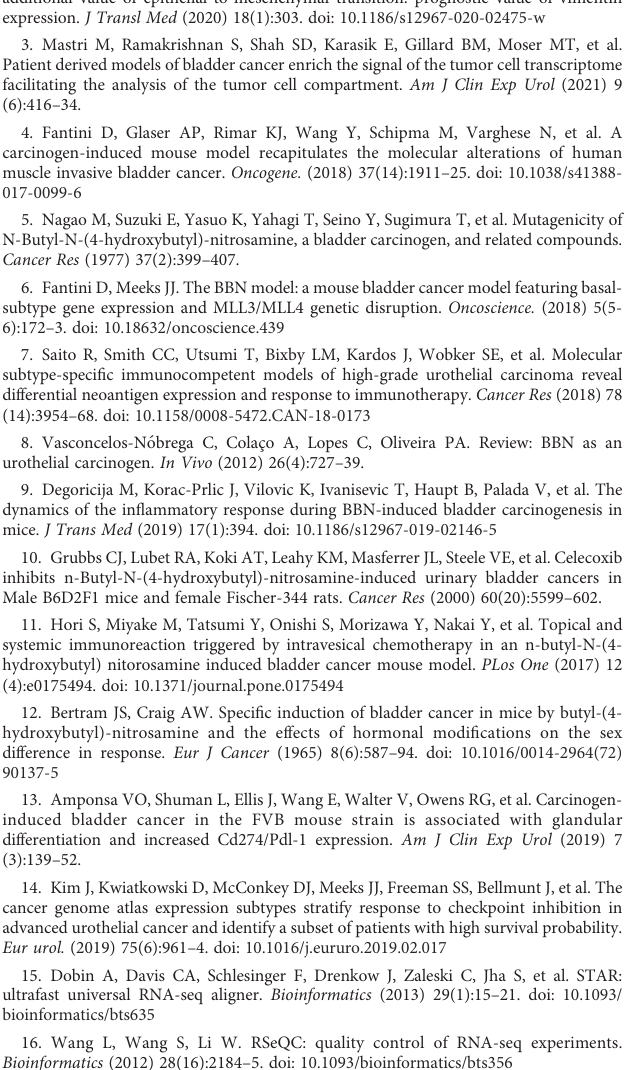
SUPPLEMENTARY FIGURE 5 Volcano plot depicting differential expression analysis. Highlighted genes represent signi fi cant (p.adj < 0.05, log2FC > +/-1) DEGs. SUPPLEMENTARY FIGURE 6 Top enriched pathways in male and female transcriptomes via GSEA. Highlighted pathways represent signi fi cant enrichments (p.adj < 0.05). SUPPLEMENTARY TABLE 1 Gene list of differential expression analysis of male and female Ba/Sq BURP tumor lines. Table representing all signi fi cant (p.adj < 0.05, log2FC > +/-1) DEGs derived fromcomparisonof maleandfemaleBa/SqBURPtumorlines. Genesarerankedby log2FC from the most downregulated in male/female to the most upregulated in